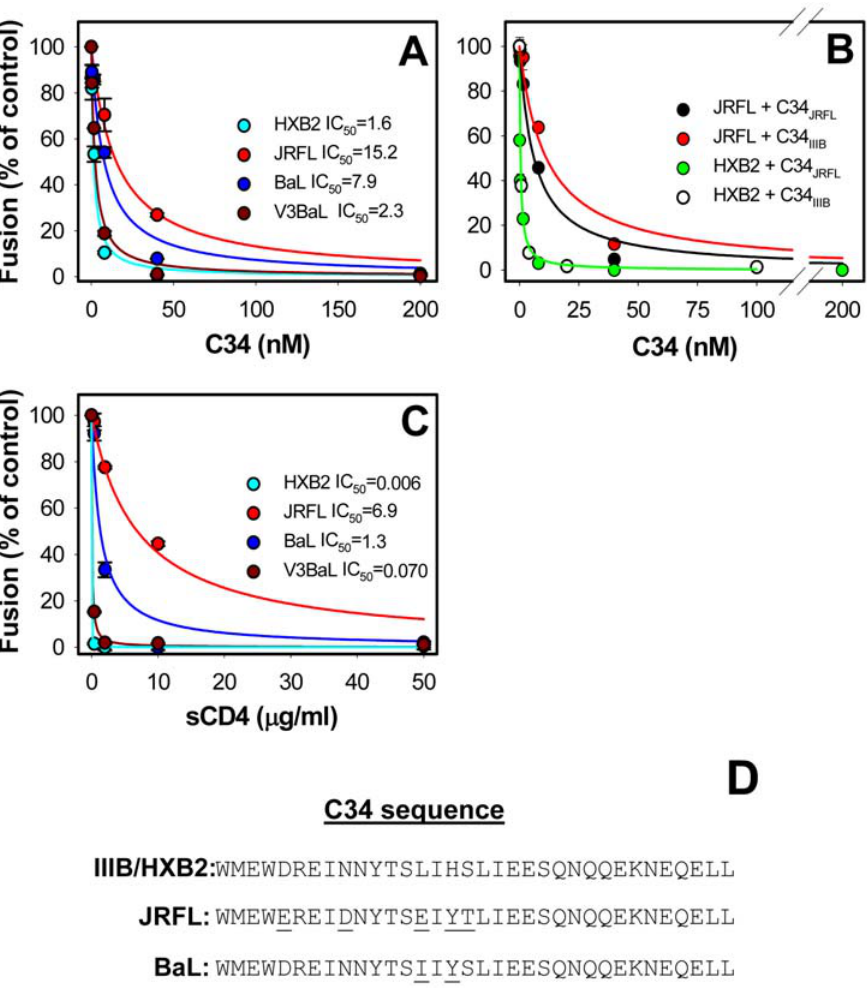
Figure 5. HIV-1 inhibition by the C34 peptide and inactivation by soluble CD4. (A) Viruses were pre-bound to TZM-bl cells and allowed to fuse for 90 min in the presence of varied concentrations of C34 derived from the HIV-1 IIIB strain. The solid lines were obtained by curve fitting experimental data using the following equation: Fusion=1/(1 + [C34]/IC 50 ), where [C34] is the C34 concentration (see Table 2 for the IC 50 values). (B) Viruses were fused with TZM-bl cells in the presence of different concentrations of C34 derived from either IIIB or JRFL gp41 (denoted C34 IIIB and C34 JRFL , respectively). (C) HIV-1 inactivation by different doses of soluble CD4 was carried out as described in Materials and Methods. (D) Amino acid sequences of the C34 peptide derived from the IIIB/HXB2, JRFL and BaL gp41. The error bars are SEM of at least three independent